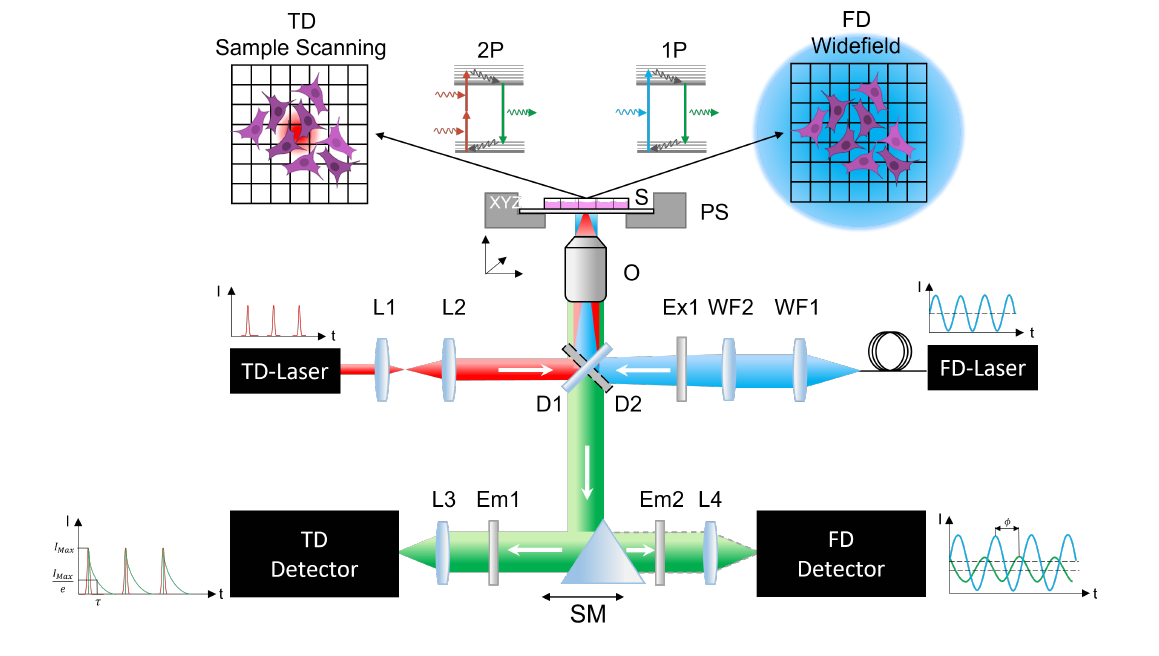
Figure 7. Schematic drawing of the optical setup. The excitation beam path for the TD setup is indicated in red. The fluorescence (green) for each pixel is detected with a single photon detector by switching the selection mirror SM to the right position. The widefield excitation beam path for the FD setup is shown in blue. Because one-photon excitation is used in FD and two-photon excitation is used in TD, the dichroic mirror D1 differs from D2 , thus excluding a simultaneous measurement. Instead, individual filter cubes, one containing the excitation filter Ex1 and dichroic mirror D1 and the other containing D2 , are placed in the beam path depending on the measurement. L: lens,